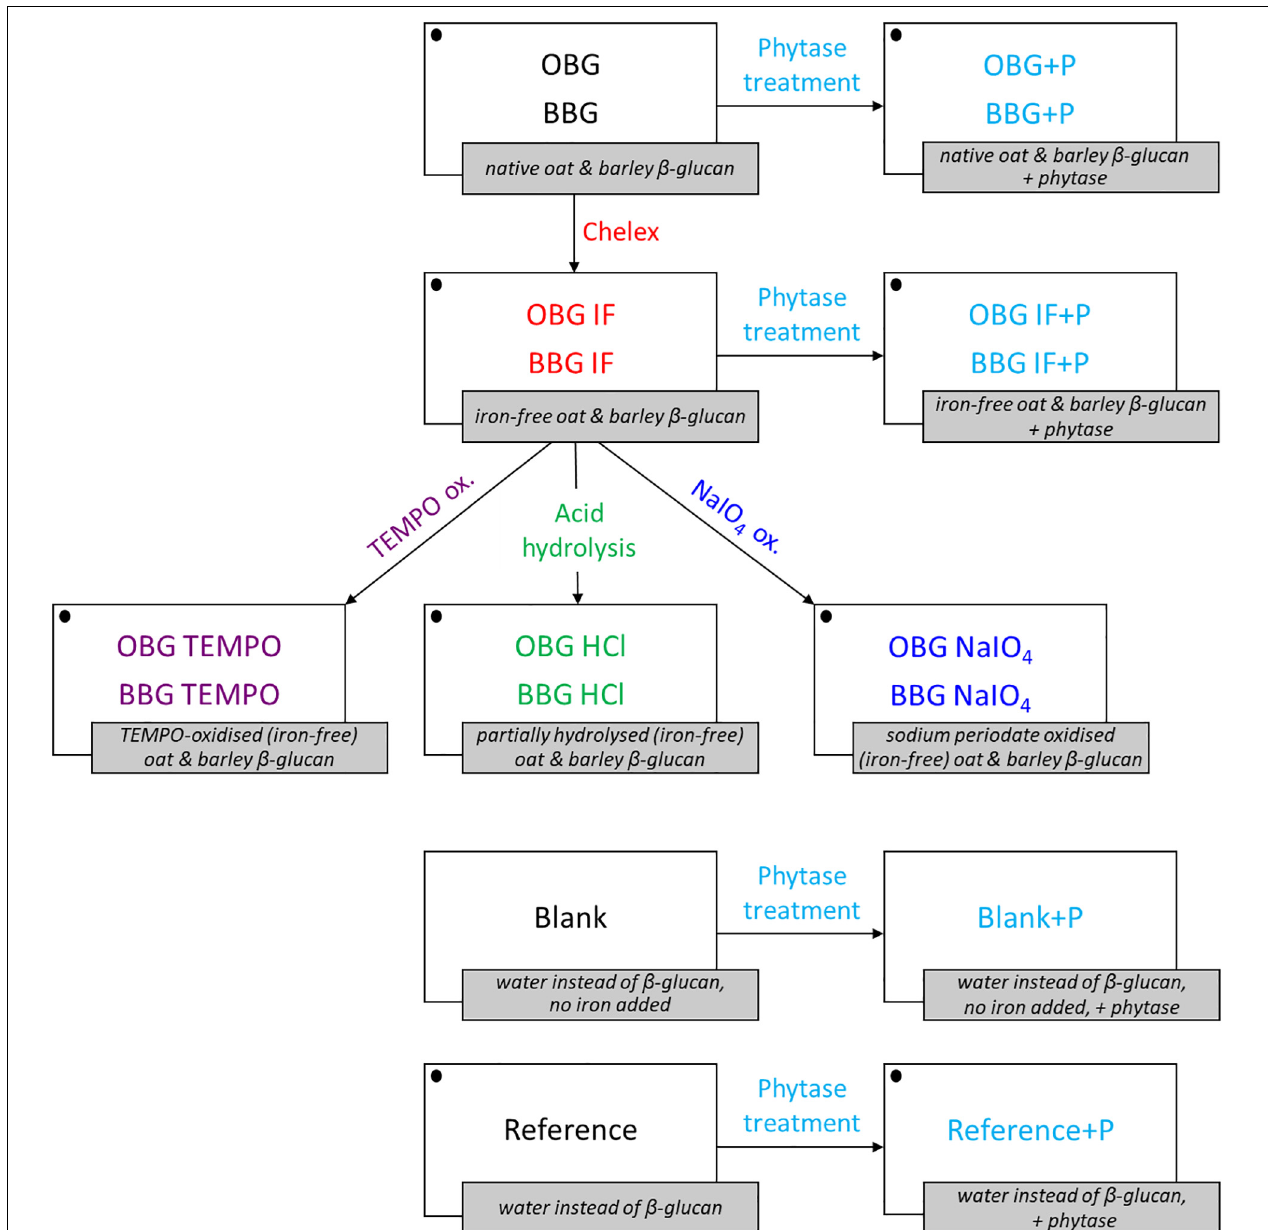
FIGURE 1 | Overview of the β -glucan extract samples, treatments, blanks, and references used for the in vitro digestion iron availability experiments. Iron is added for all samples and references (symbolized with • in the figure) with the exception of the blanks (blank and blank+P). OBG, oat β -glucan; BBG, barley β -glucan; IF, “iron-free” (Chelex-treated) samples; +P, phytase treated